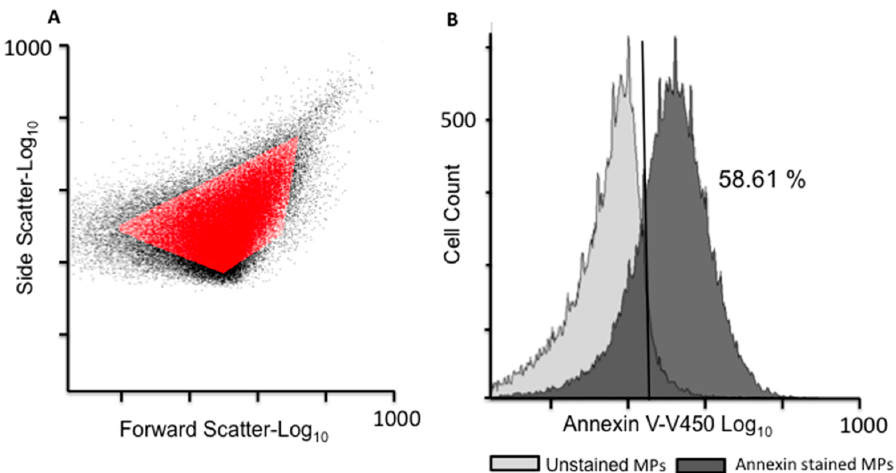
Figure 1. EVs (extracellular vesicles) isolated from VLB 100 cells. ( A ) EVs isolated from VLB 100 cells were analysed via flow cytometry (FCM) and defined as elements smaller in diameter than 1 µm. Latex beads of 0.3–1.1 µM (Sigma, Castle Hill, Australia) were used to define the upper limit of the forward scatter. The threshold was set on the side scatter to prevent exclusion of the smallest events; ( B ) 58.61% of the gated EV population was positive for Annexin V-V450. Data is representative of a typical experiment (n = 3).